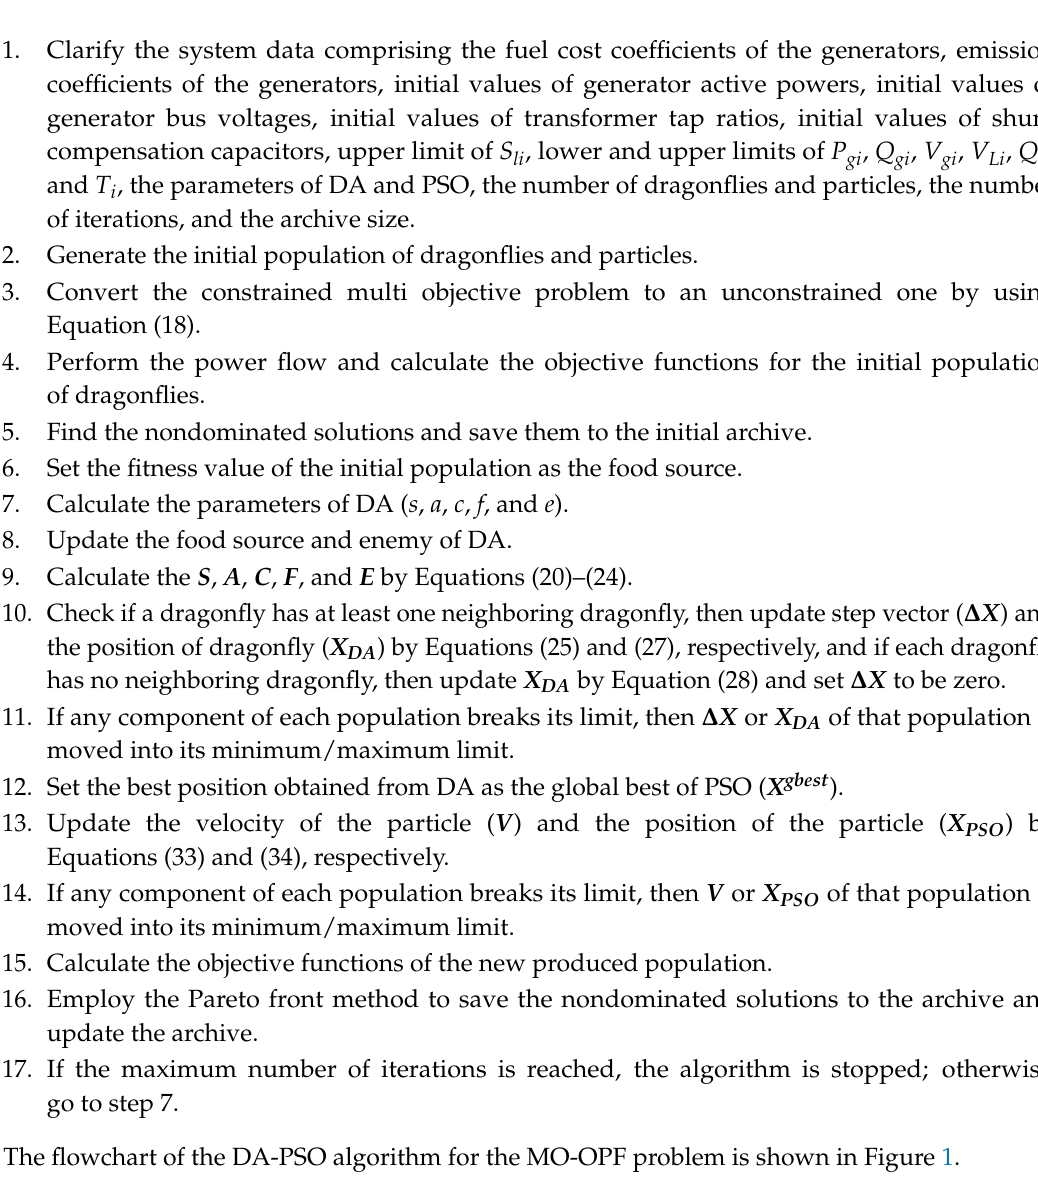
Clarify the system data comprising the fuel cost coefficients of the generators, emission coefficients of the generators, initial values of generator active powers, initial values of generator bus voltages, initial values of transformer tap ratios, initial values of shunt compensation capacitors, upper limit of S li , lower and upper limits of P gi , Q gi , V gi , V Li , Q ci , and T i , the parameters of DA and PSO, the number of dragonflies and particles, the number of iterations, and the archive